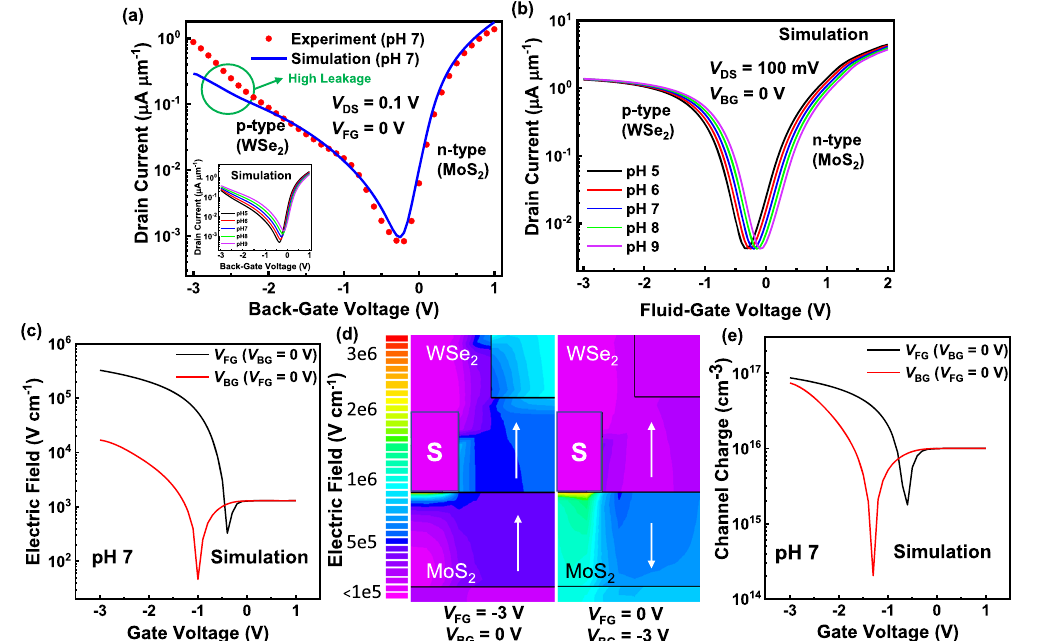
Fig. 4 TCAD simulations. a TCAD simulations calibrated against experimental transfer curve at pH = 7 in the reverse-sweep direction for the WSe 2 (top)/MoS 2 (bottom) ISFET. The inset shows simulation results for pH values ranging between 5 and 9. b Drain current vs fl uid-gate voltage characteristics at different pH values, extracted using TCAD simulations. c Simulated magnitude of the electric fi eld across the WSe 2 channel v/s gate voltage (for V FG and V BG when the other is set to 0 V). d Simulated electric fi eld contours with applied V FG and V BG (arrows indicate the fi eld direction). e Simulated density of channel (WSe 2 ) charge v/s gate voltage (for V FG and V BG when the other is set to 0